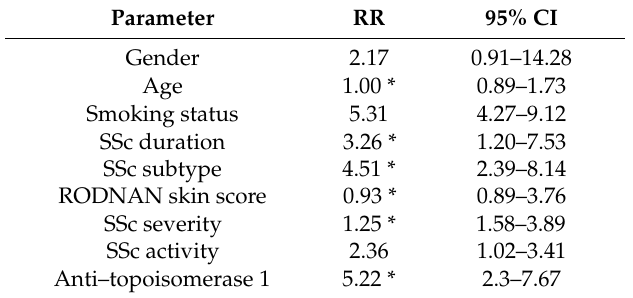
Table 3. Associations between the number of teeth with PDL space widening and SSc severity.